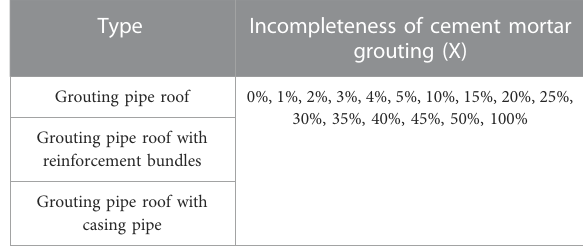
TABLE 1 Parameter settings for numerical